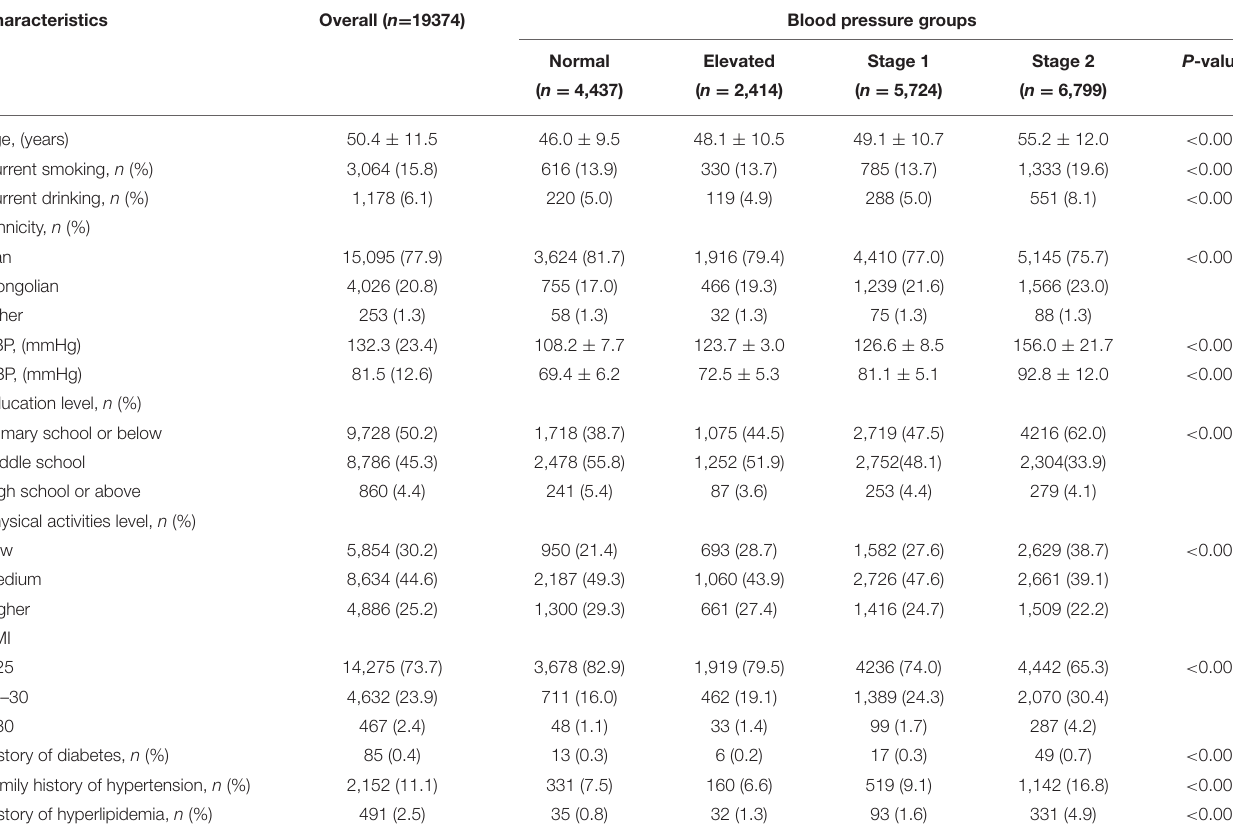
TABLE 1 | Baseline characteristics of study population ( n =